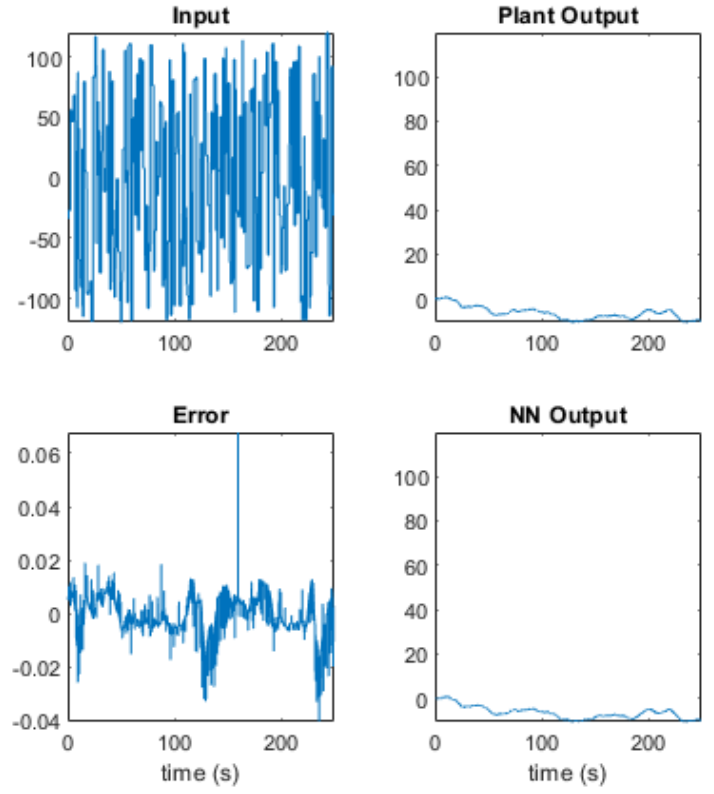
Figure 34. The training data of the neural network model.